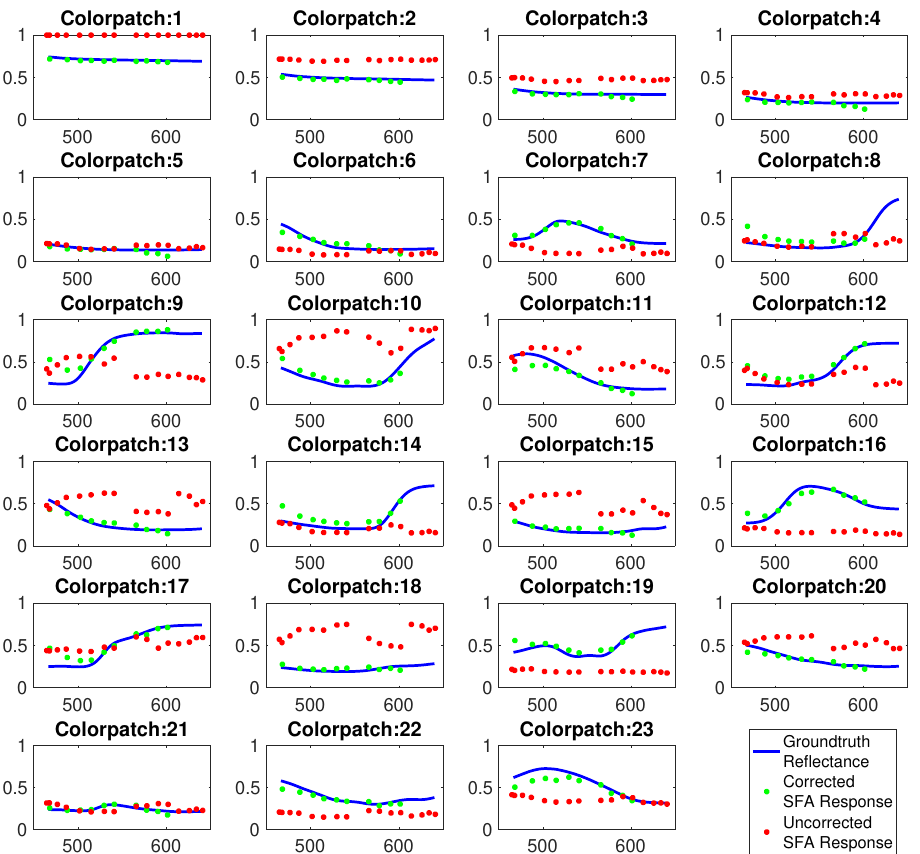
Figure 10. Spectral reflectance of Gretag MacBeth color patches measured by full spectral camera (blue), uncorrected spectral estimates of SFA setup (red), spectral corrected estimates (green).